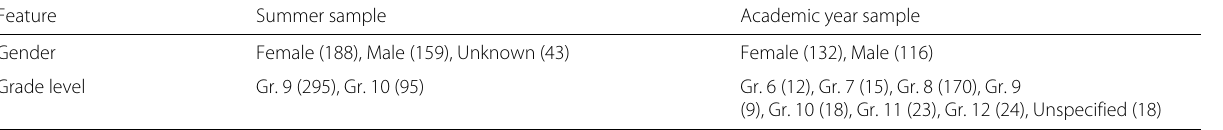
Table 7 Distribution of student gender and grade level in the summer and academic year sample populations